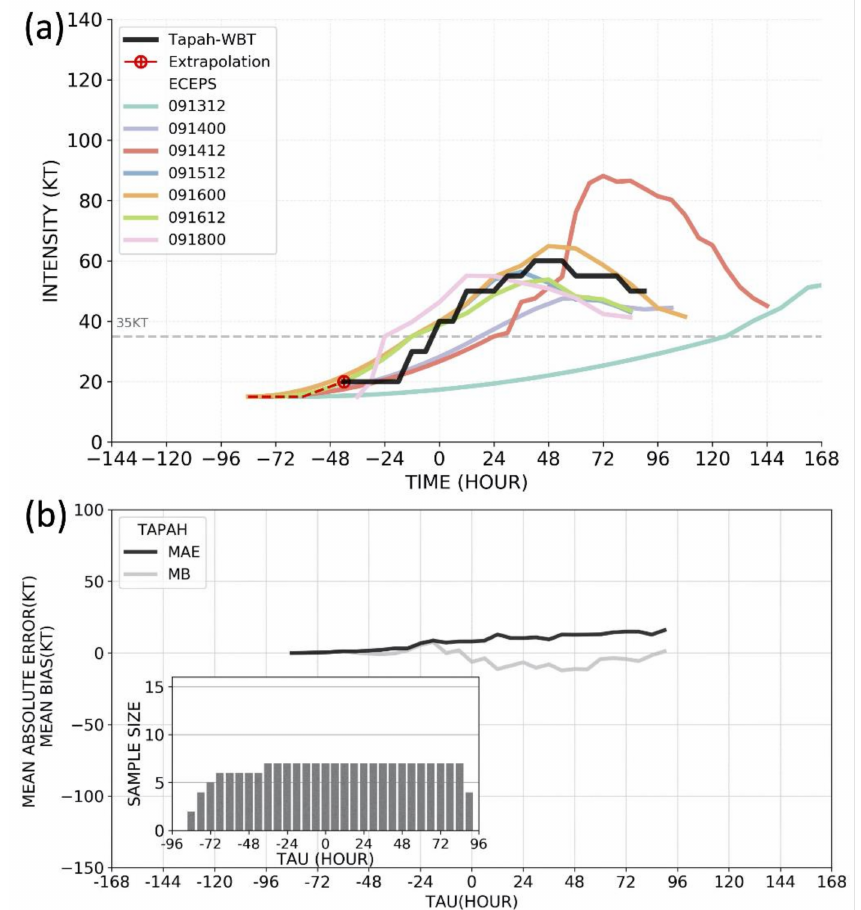
Figure 6. ( a ) Modified WAIP intensity (knots) forecast verifications for the ECEPS-predicted T2F (35 kt) as in Figure 4b, except for the pre-TS Tapah (2019) circulations. ( b ) Intensity MAEs (solid line) and intensity MBs (gray line) as in Figure 4d,f except for pre-TS